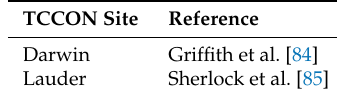
Table A2. Total Carbon Column Observing Network (TCCON) sites with the references to the data used in this